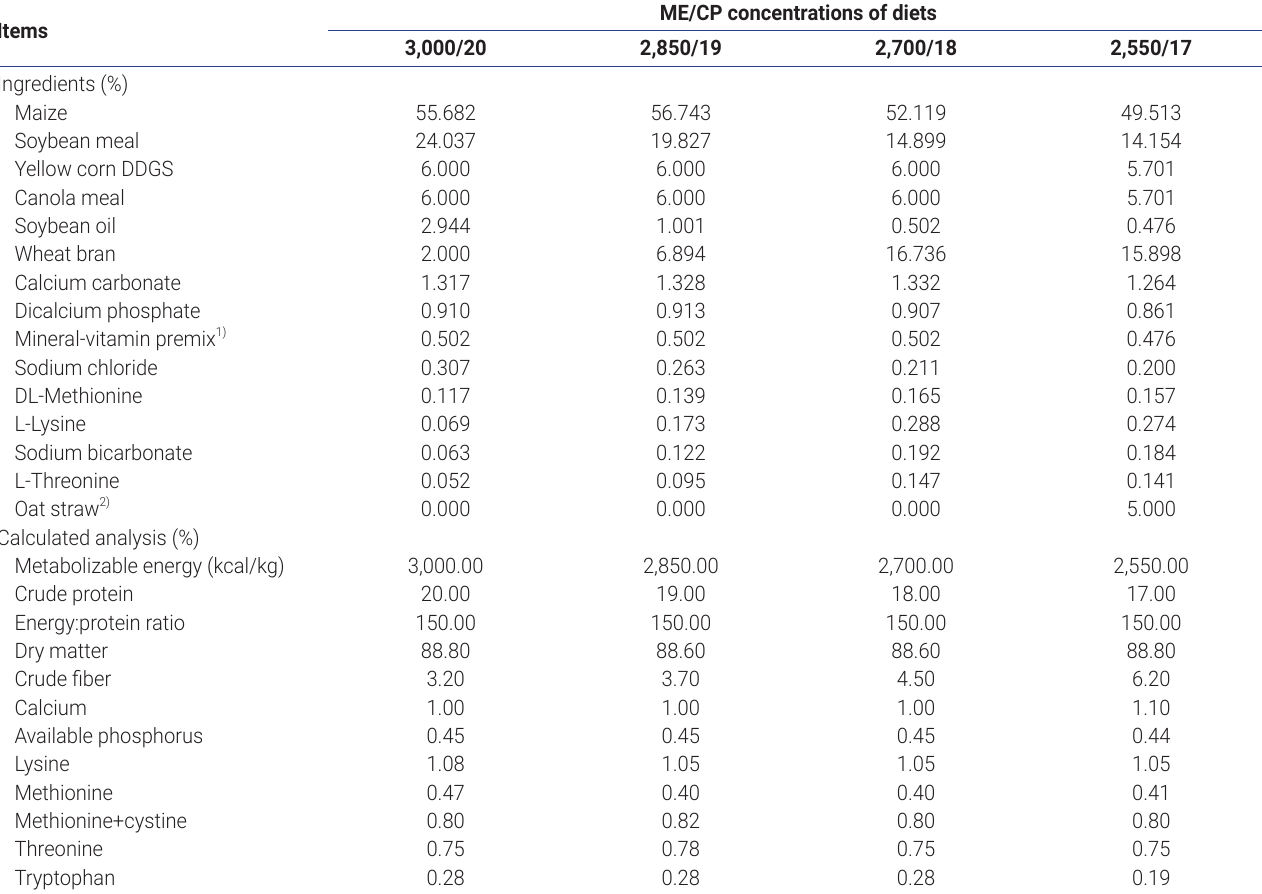
Table 1. Composition (%) and calculated analysis of the experimental diets used